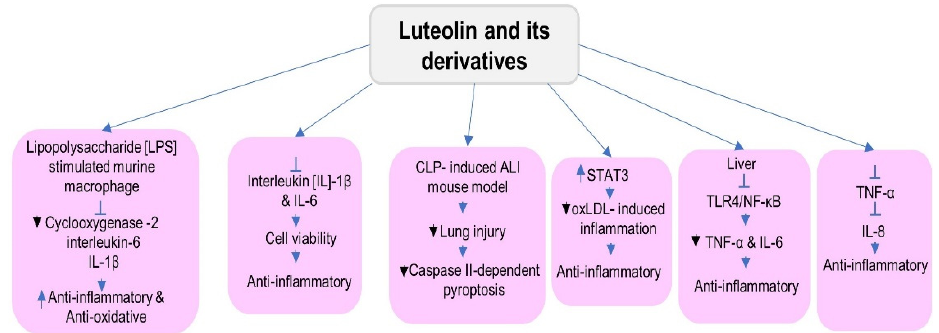
Figure 5. The figure representing the anti-inflammatory mechanism of luteolin in various